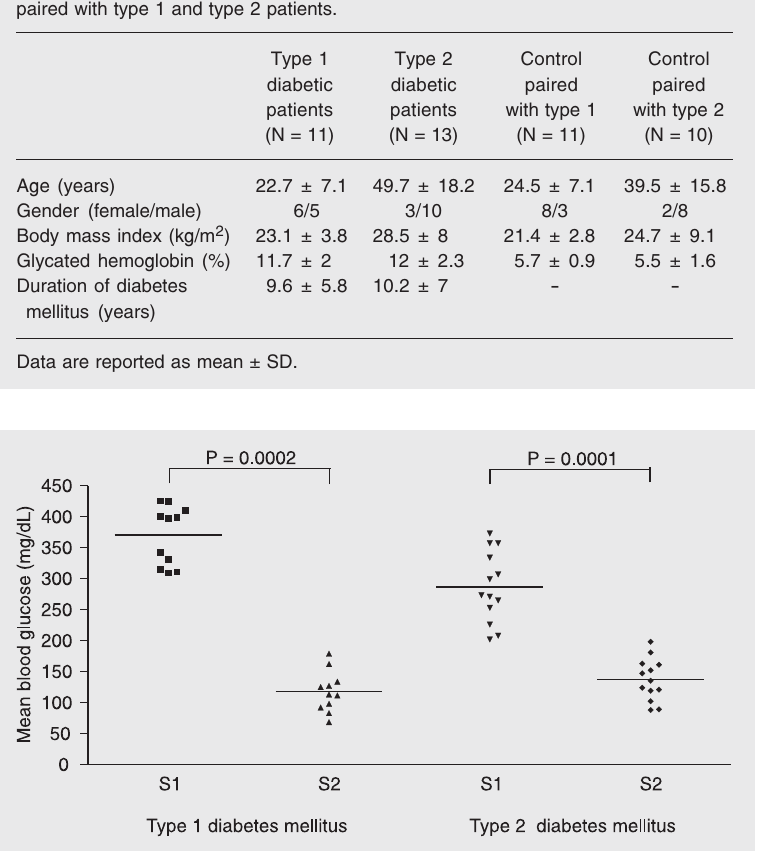
Figure 1 . Daily mean glucose levels of type 1 and type 2 diabetic patients on the first (sample 1, S1) and last (sample 2, S2) days of hospitalization. There was a significant reduction in the daily mean blood glucose levels in both type 1 and 2 diabetic groups. The Student t -test was used. The horizontal lines indicate the mean for each